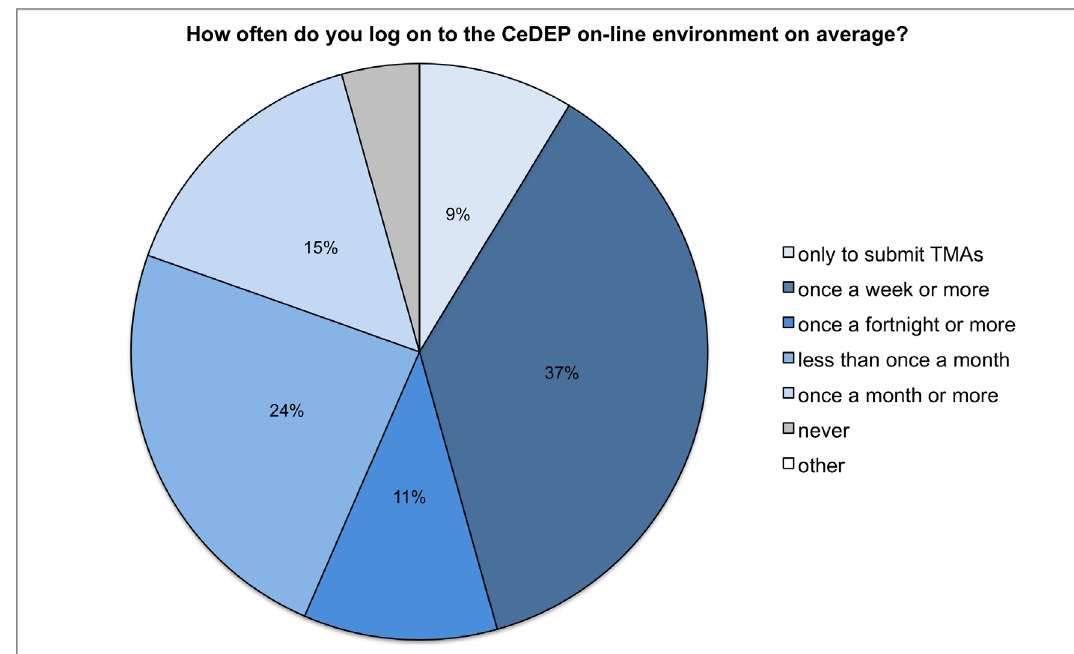
Figure 3 . Student use of the online learning